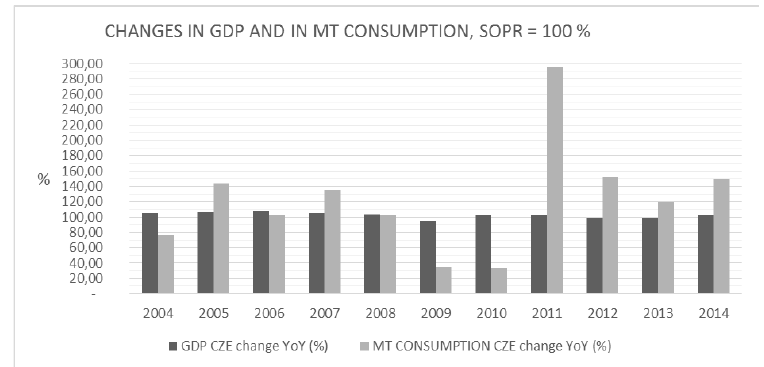
Fig. 5 - Annual changes in the country’s GDP and consumption MT in the Czech Republic from 2004 to 2014, constant prices. Source: CZSO, (2017) . Association of Engineering Technology: Reports on the state of Machine Tools Branch in the Czech Republic 2007 - 2014.